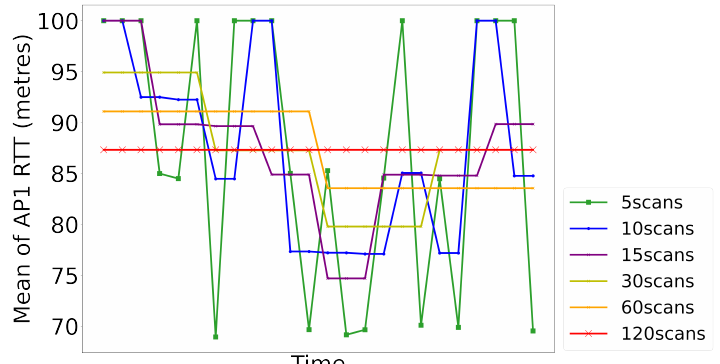
Figure 17. The mean value of AP1’s RTT measures with different sampling sizes at a RP. The value of 100 indicates that there is no WiFi signal at this RP. Datasets of different sample sizes contain signal patterns of different time